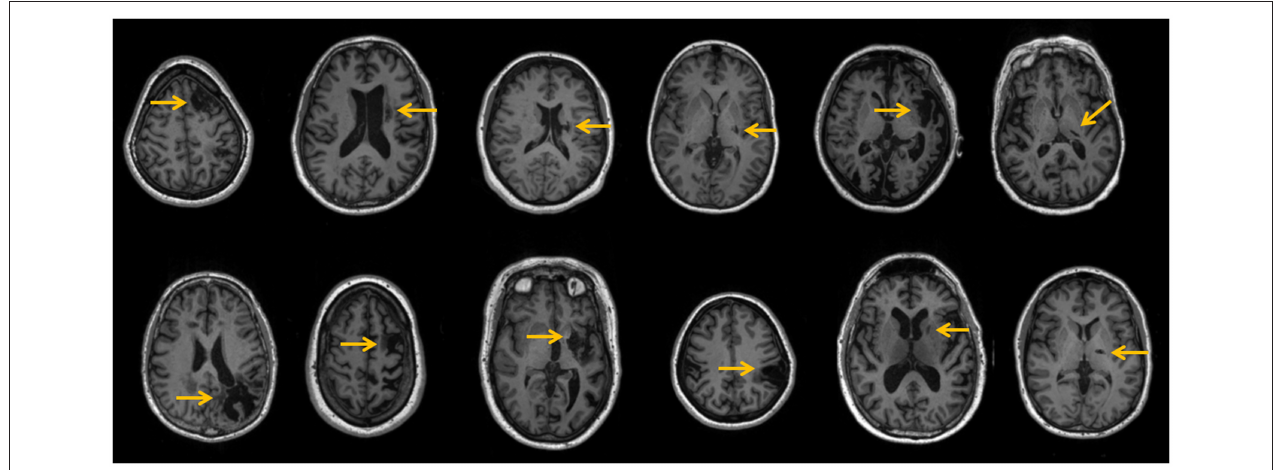
FIGURE 2 | Patients’ stroke lesions (yellow arrows) on T1-weighted anatomical slices.